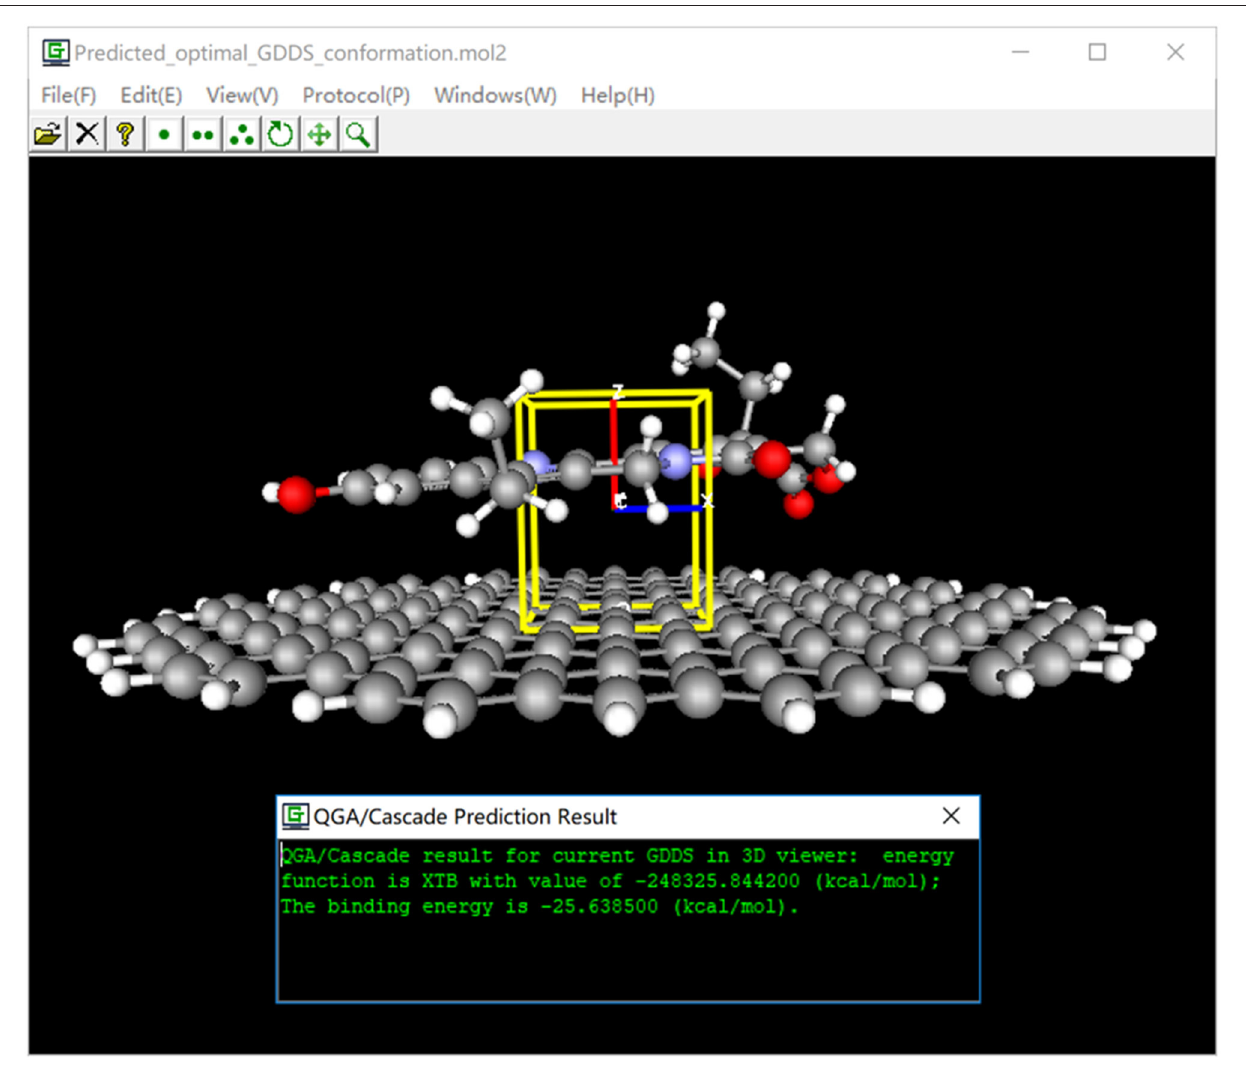
FIGURE 6 | Visualization of graphene-based drug delivery system (GDDS) prediction/screen